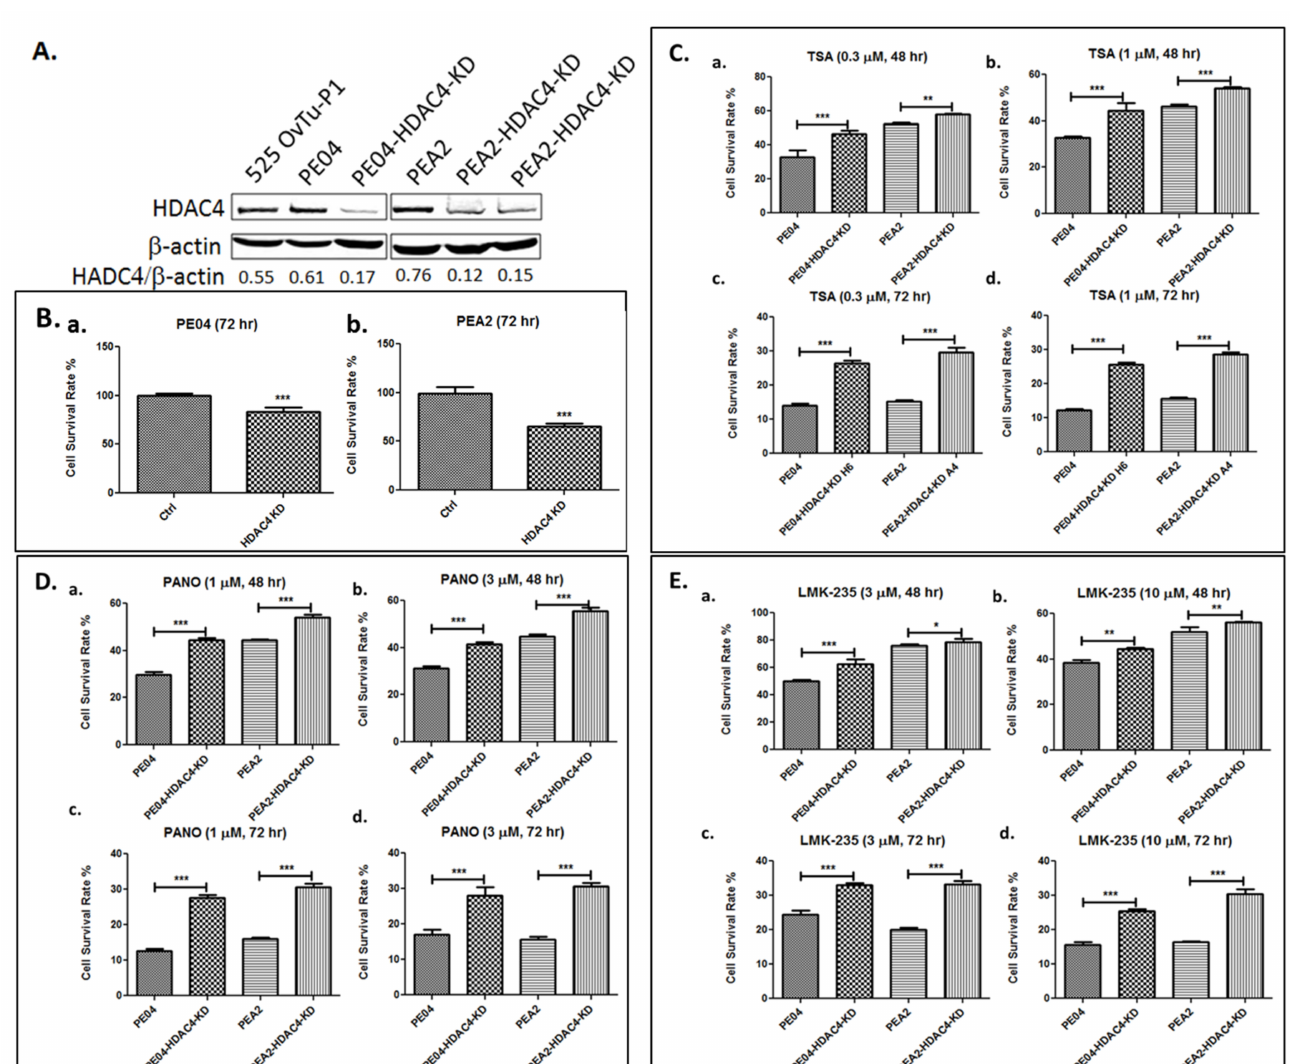
Figure 3. HDAC4-KD inhibited HDACi sensitization in PE04 and PEA2 cells. ( A ). HDAC4-KD PE04 and PEA2 cell lines generated using shRNAs. ( B ). HDAC4-KD PE04 and PEA2 cell lines reduced cell numbers (measured by MTT). ( C – E ). HDAC4-KD increased cell resistance to HDACis (TSA, PANO and LMK-235). The MTT values for each individual cell line with solvent treatment were used as 100% in ( B – D ). All experiments were repeated means standard deviation (SD). * p < 0.05; ** p < 0.01; *** p < ±